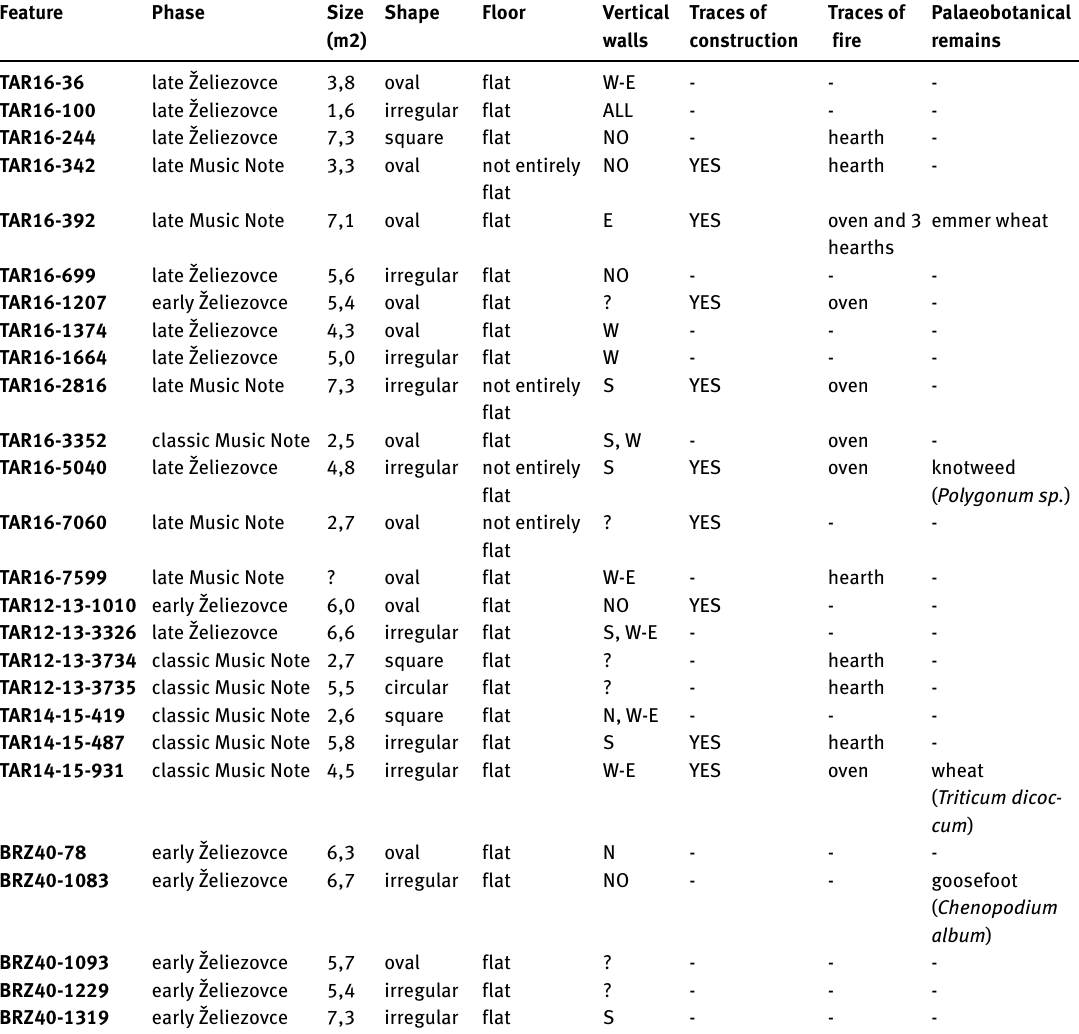
Table 1: Characteristic of the features interpreted as sunken-floored